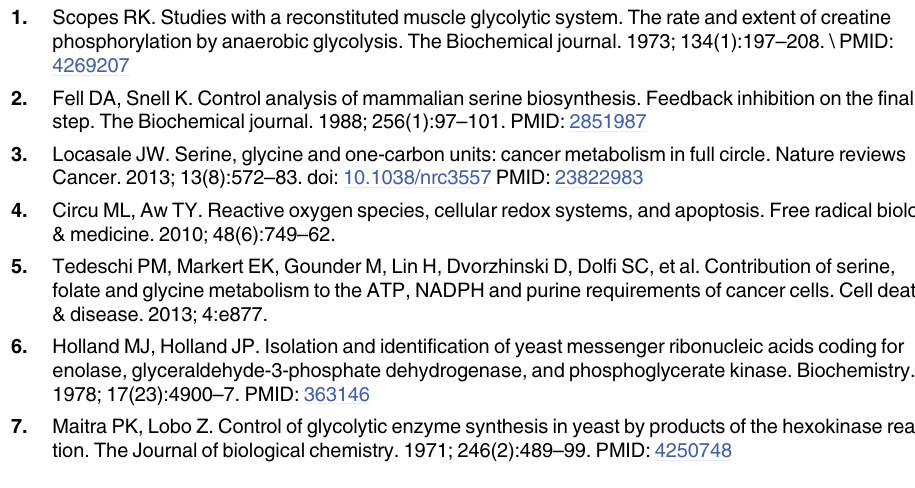
S17 Fig. Morphological changes of stable PGK1 knockdown and put-back cells subjected to menadione treatment. Stable HEK293T cells were treated with menadione of the indicated concentration for 3 hr. The changes in cell morphology were monitored under the microscope. Scale bars are 200 μ m. (TIF) S1 Table. The list of oligonucleotides and primer sequences used in this study. (DOCX) S1 Text. Supplementary materials and methods. For more details about antibodies, plasmids, cell culture and treatment, immunoprecipitation and western blotting, RNA isolation and quantitative real-time PCR, animal experiments, RNA interference, protein concentration determination, protein expression and purification, pull-down assay, in vitro deacetylation assay, HDAC3 activity assay, measurement of intracellular ATP levels, flow cytometry, liquid chromatography mass spectrometry (LC-MS), extracellular acidification rate (ECAR), glucose depletion assay, glycogen content measurement, measurement of intracellular ROS levels, or cell survival assay, please refer to S1